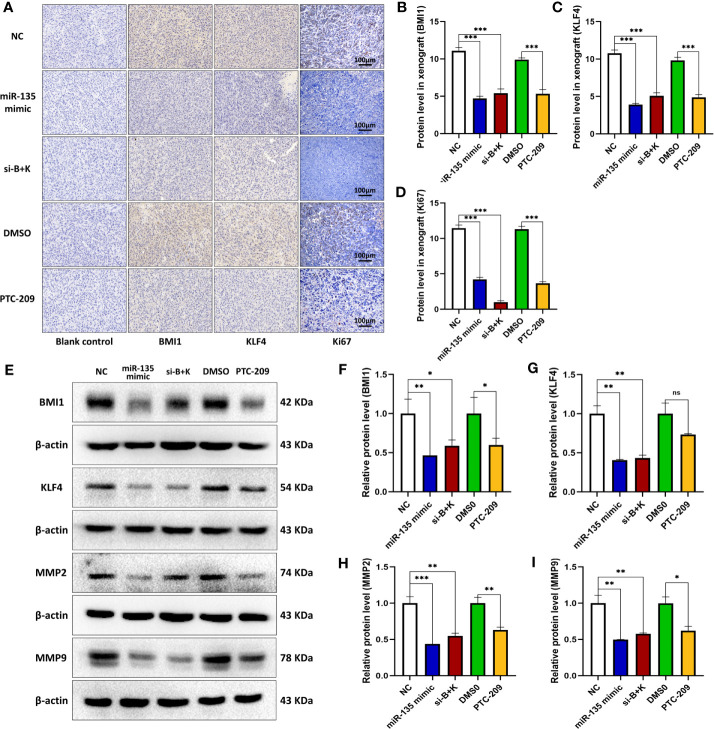
miR-135a, combination therapy, and PTC-209 suppression of BMI1 and KLF4 in mouse OS cell xenografts. (A) Immunohistochemistry. The mouse OS cell xenografts were resected from the nude mice and subjected to tissue processing, embedding, sectioning, and immunohistochemistry. Scale bar, 100 μm. (B–D) The graph of the quantified data of immunohistochemical staining of BMI1, KLF4, and Ki67. (***p < 0.001; n = 10). (E) Western blot. The mouse OS cell xenografts were resected from the nude mice and subjected to protein extraction and western blot. (E–I) The graph of the quantified data of the western blots (ns p>0.05; *p <0.05; **p < 0.01; ***p < 0.001; n = 3). The data were expressed as the mean ± SEM. ns, not significant.